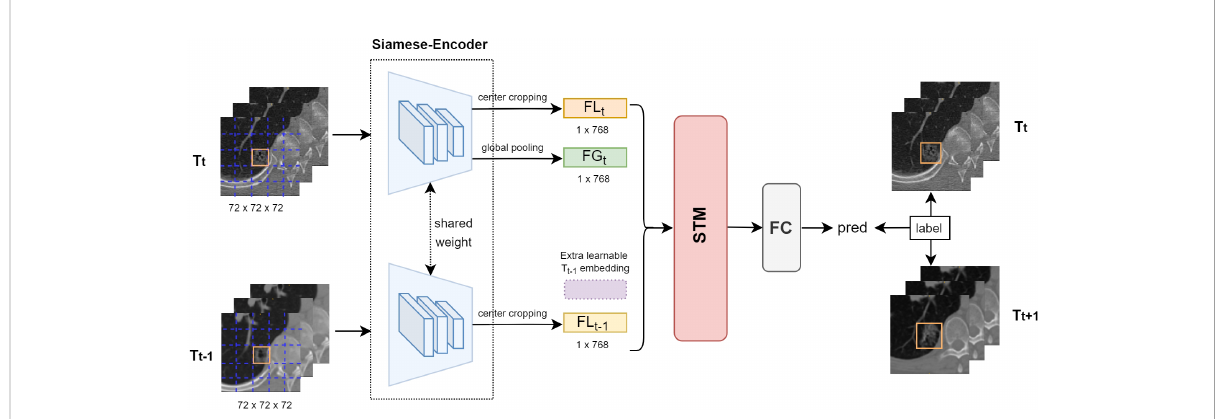
FIGURE 4 Overview of our proposed deep learning-based growth prediction model (called SiamModel), where FG t , FL t , and FL t − 1 represent global feature embedding of T t VOI, local feature embedding of T t VOI, and local feature embedding of T t − 1 VOI, respectively. The two encoders, whose backbone was ViT-B, in the Siamese-encoder shared